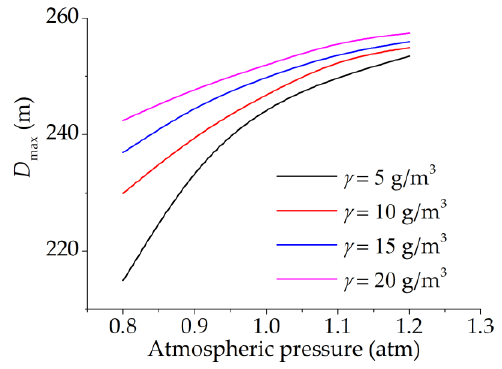
Figure 7. The variation of D max with the changing of absolute humidity and atmospheric pressure.